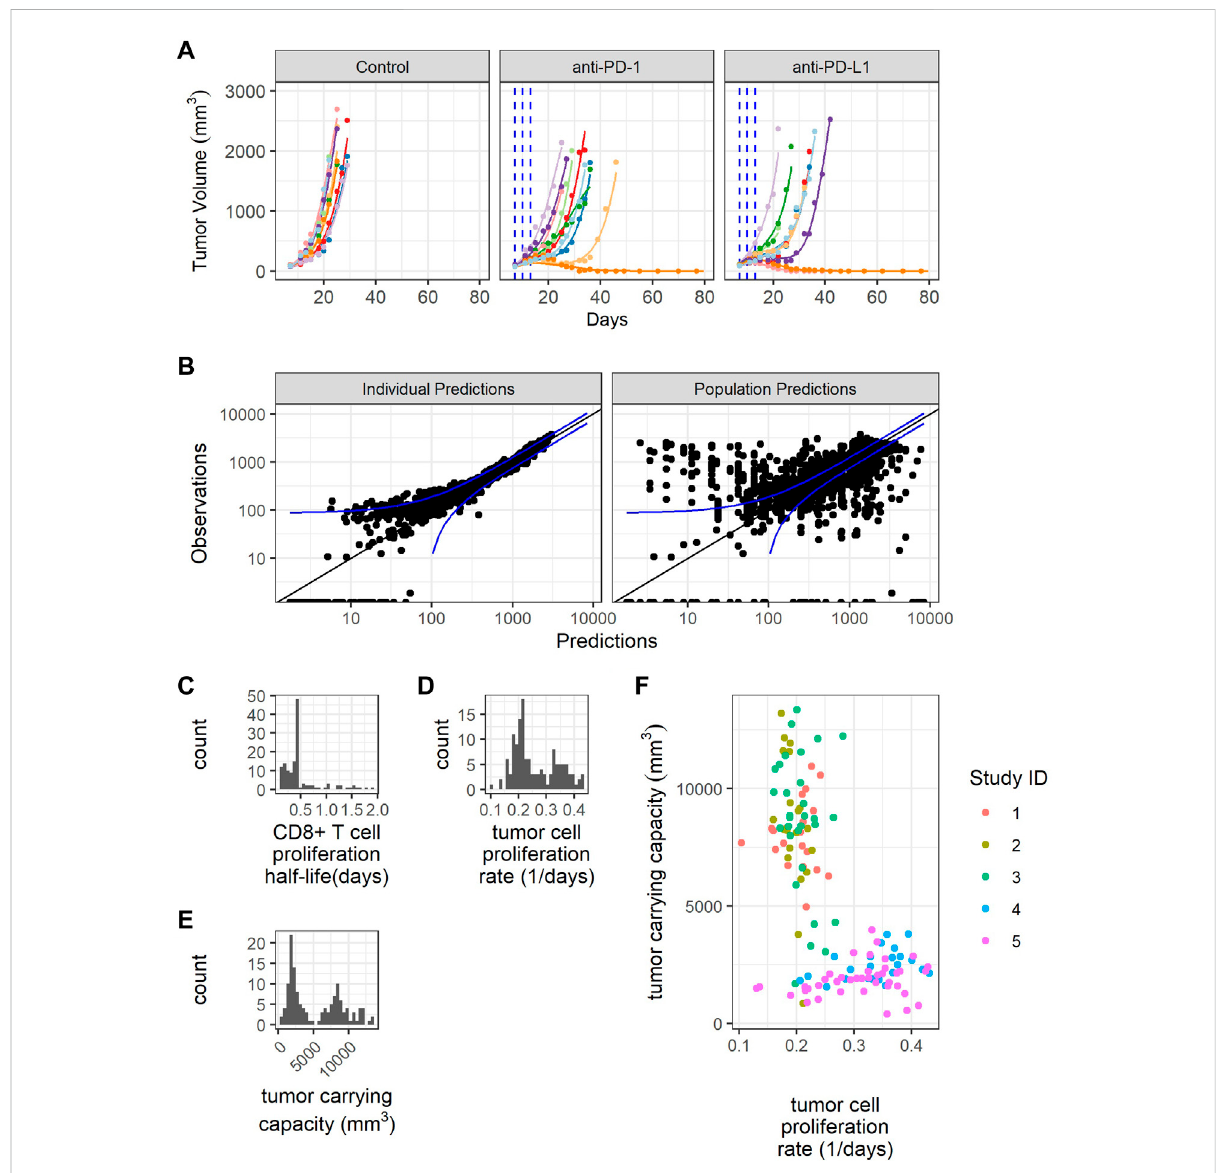
FIGURE 3 Model fi tting recapitulates inter-individual variability. (A) Representative comparison (study 3) between observed tumor volume pro fi les (coloreddots)andindividualsimulations(coloredlines)forstudy3. (B) Observationsversespredictions. (C) Distributionofmodelestimatedindividual PD-1+CD8 + T cell proliferation half-lives. (D) Distribution of model estimated individual tumor cell proliferation rates. (E) Distribution of model estimated individual tumor carrying capacities. (F) Individual tumor cell proliferation rates and tumor carrying capacities show study dependent